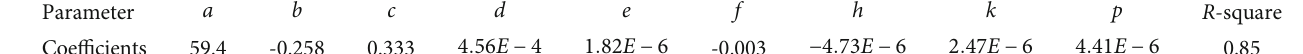
Table 7: Fitting coe ffi cients a , b , c , d , e , f , h , k , and p .